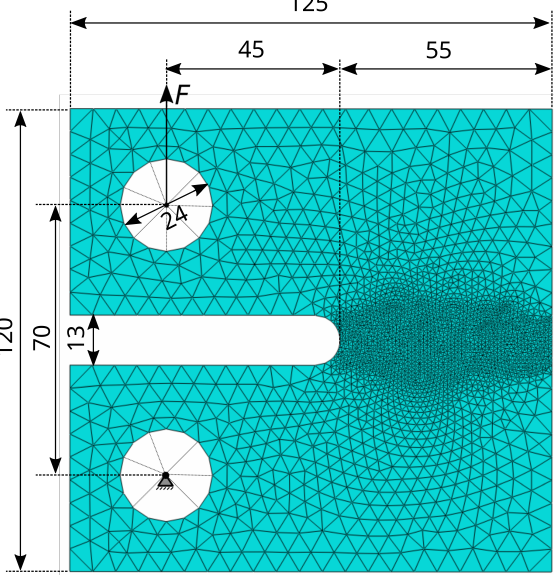
Figure 11. Domain of simulation with schematic representation of the boundary